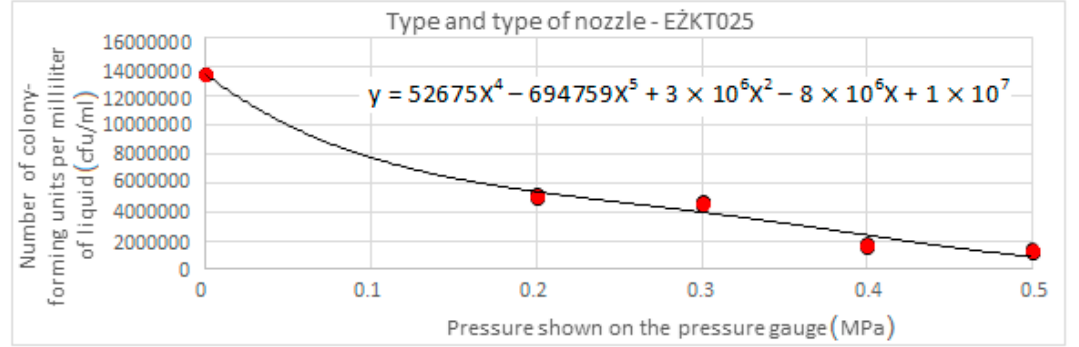
Figure 8. The influence of pressure on survival of cfu/mL of liquid for E Ż KT02. The vertical axis shows the cfu/mL values, while the horizontal axis shows the pressure (MPa) values set in the throttling valve and read in manometers.